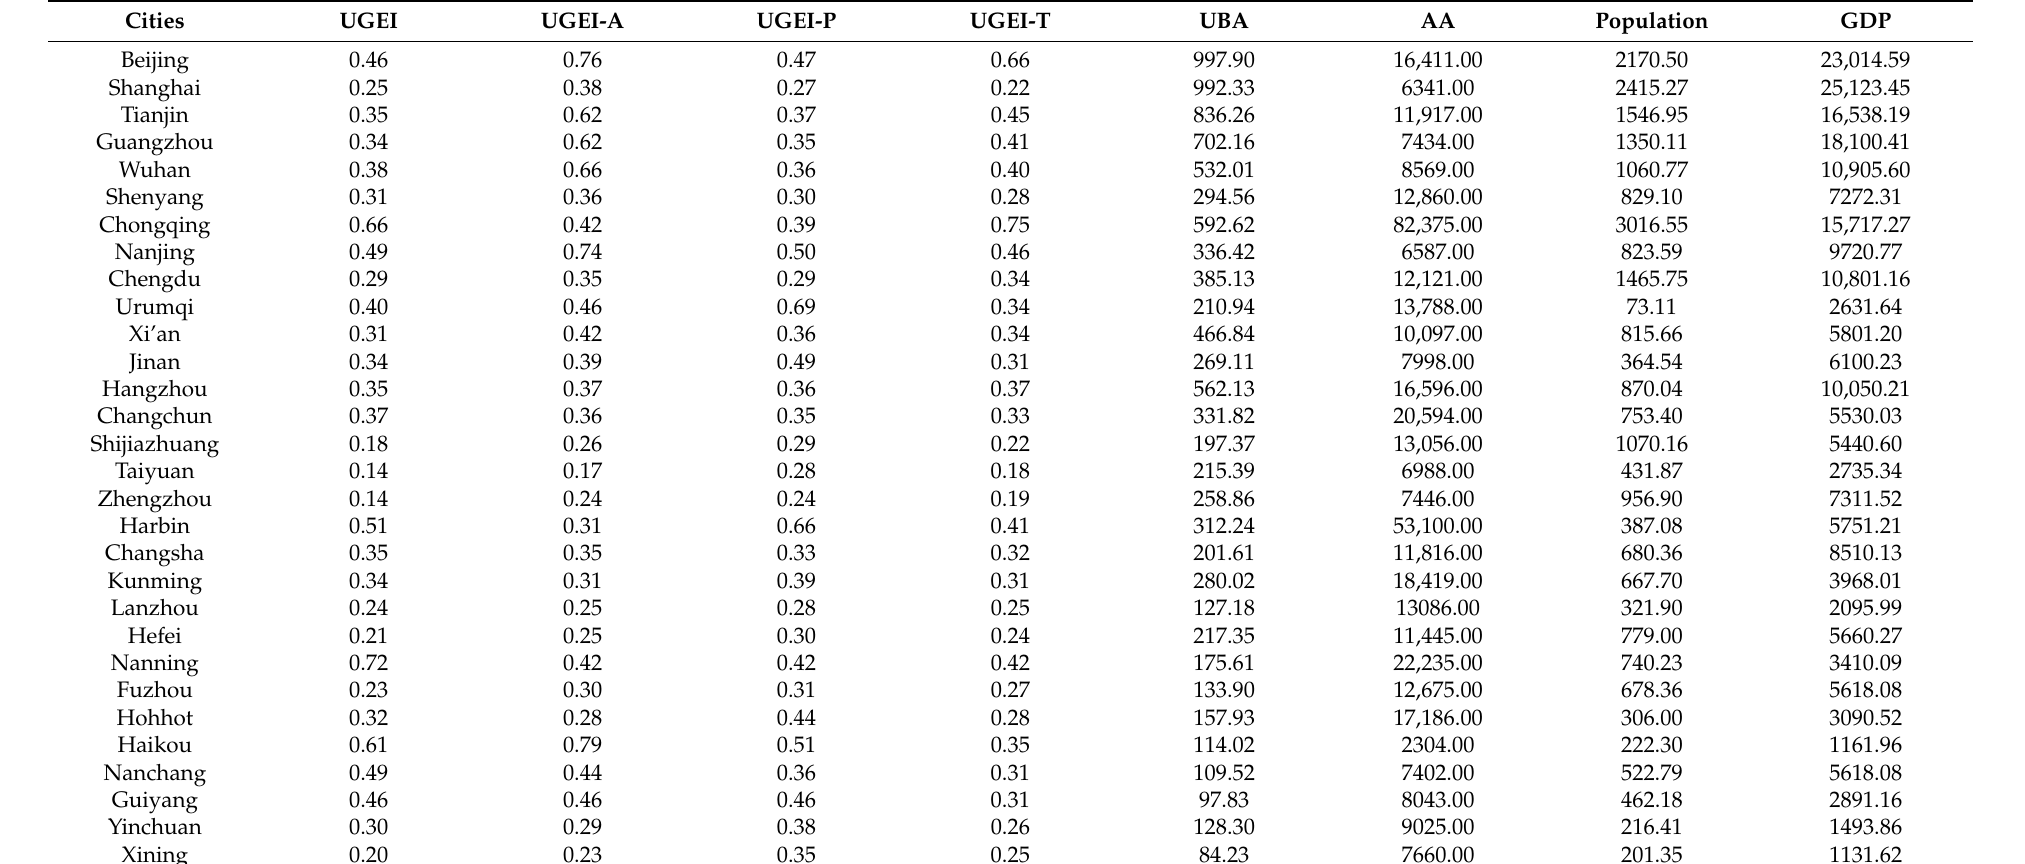
Table A3. Different types of indicators and supplementary